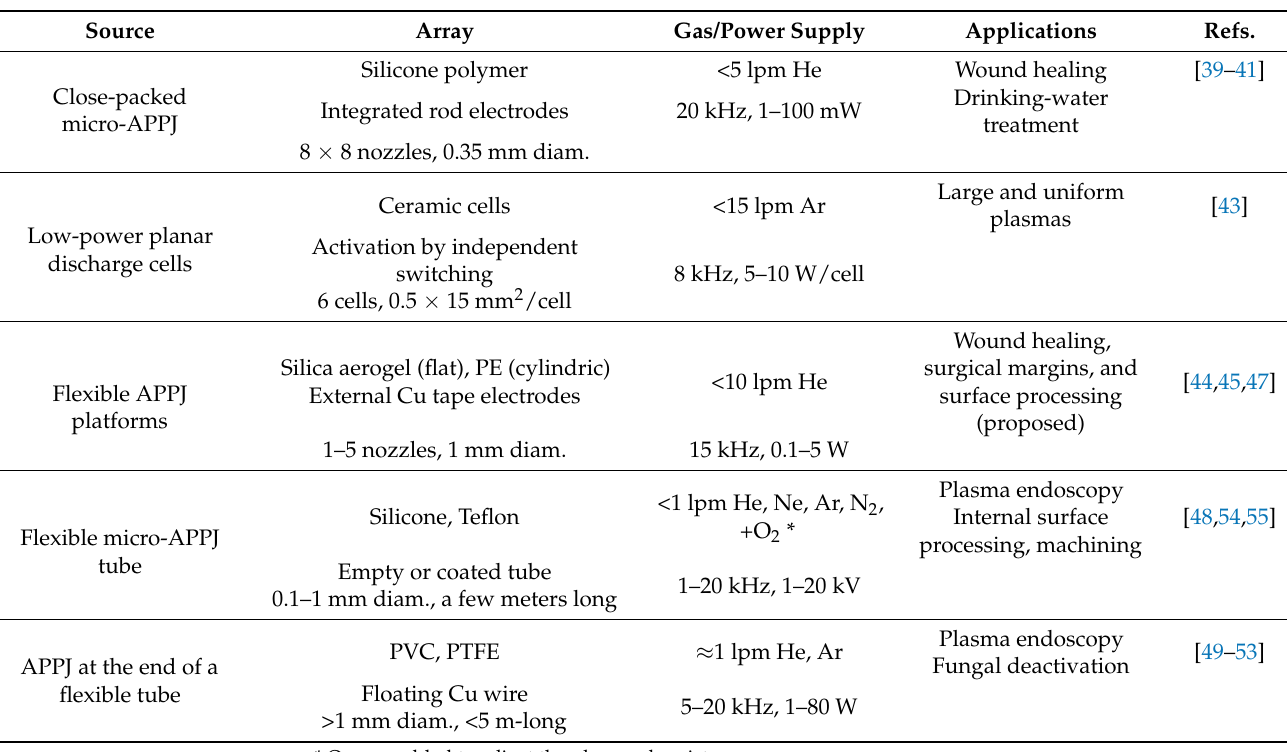
Table 1. Morphing plasma jet sources and flexible APPJ nozzles together with their characteristics, operation parameters range and intended applications.